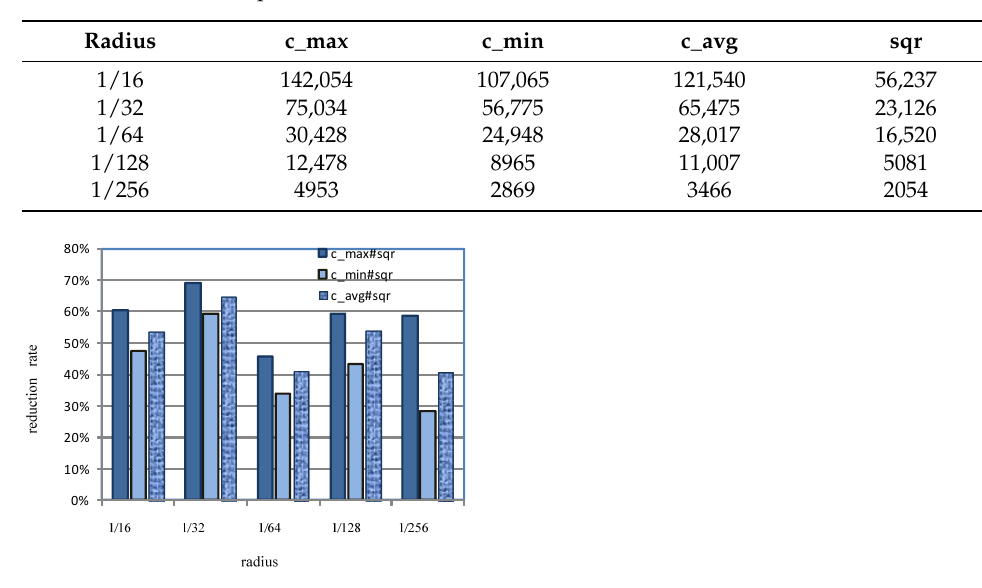
Figure 13. The reduction rates of confirmation points.